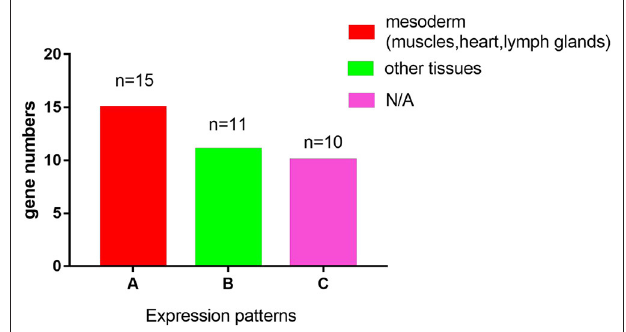
FIGURE 1 | A graphic overview of the expression patterns of the 36 LIM genes in Drosophila melanogaster . According to the FLY-FISH or FlyExpress databases, there are 15 LIM genes expressed in mesoderm including muscles, heart, or lymph glands (Columm A). It indicates that 11 LIM genes are expressed in other non- Columm A tissues (Columm B). The expression patterns of the remaining 10 LIM genes are unclear (Columm